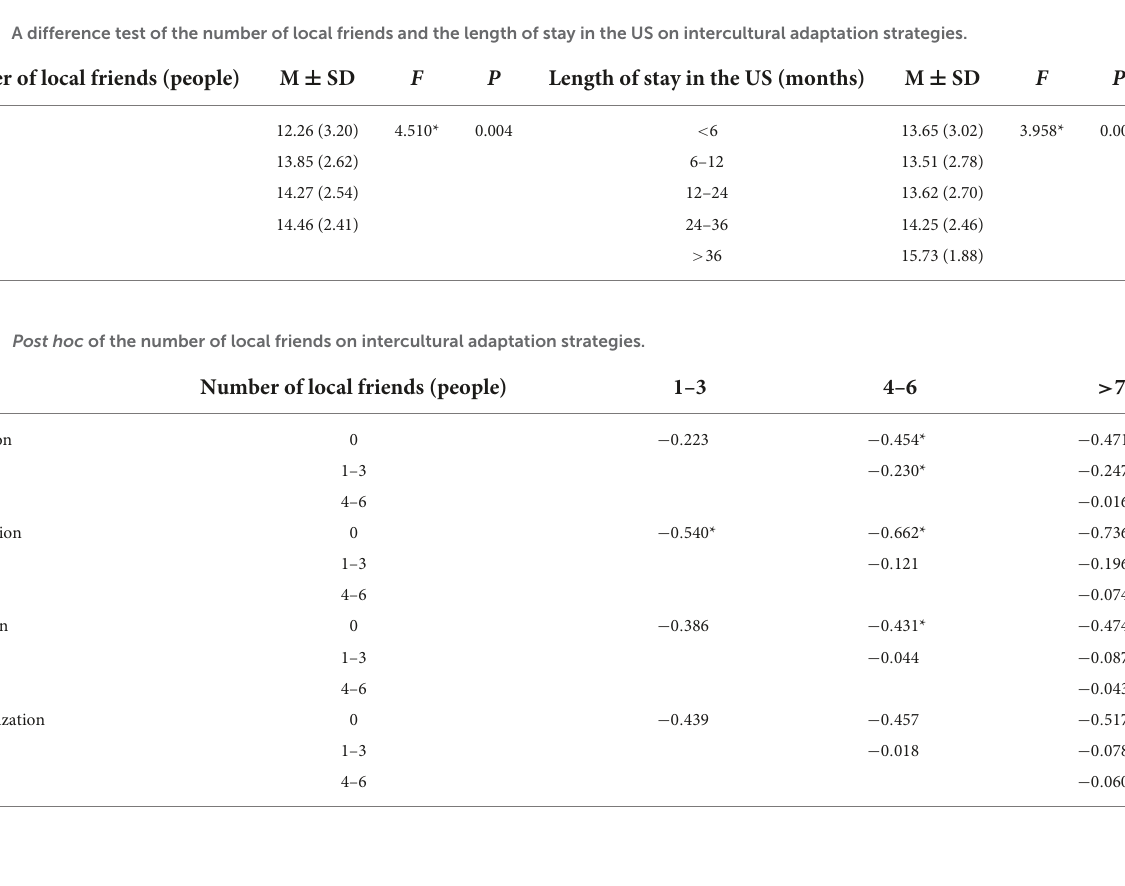
the results are shown in Figure 1